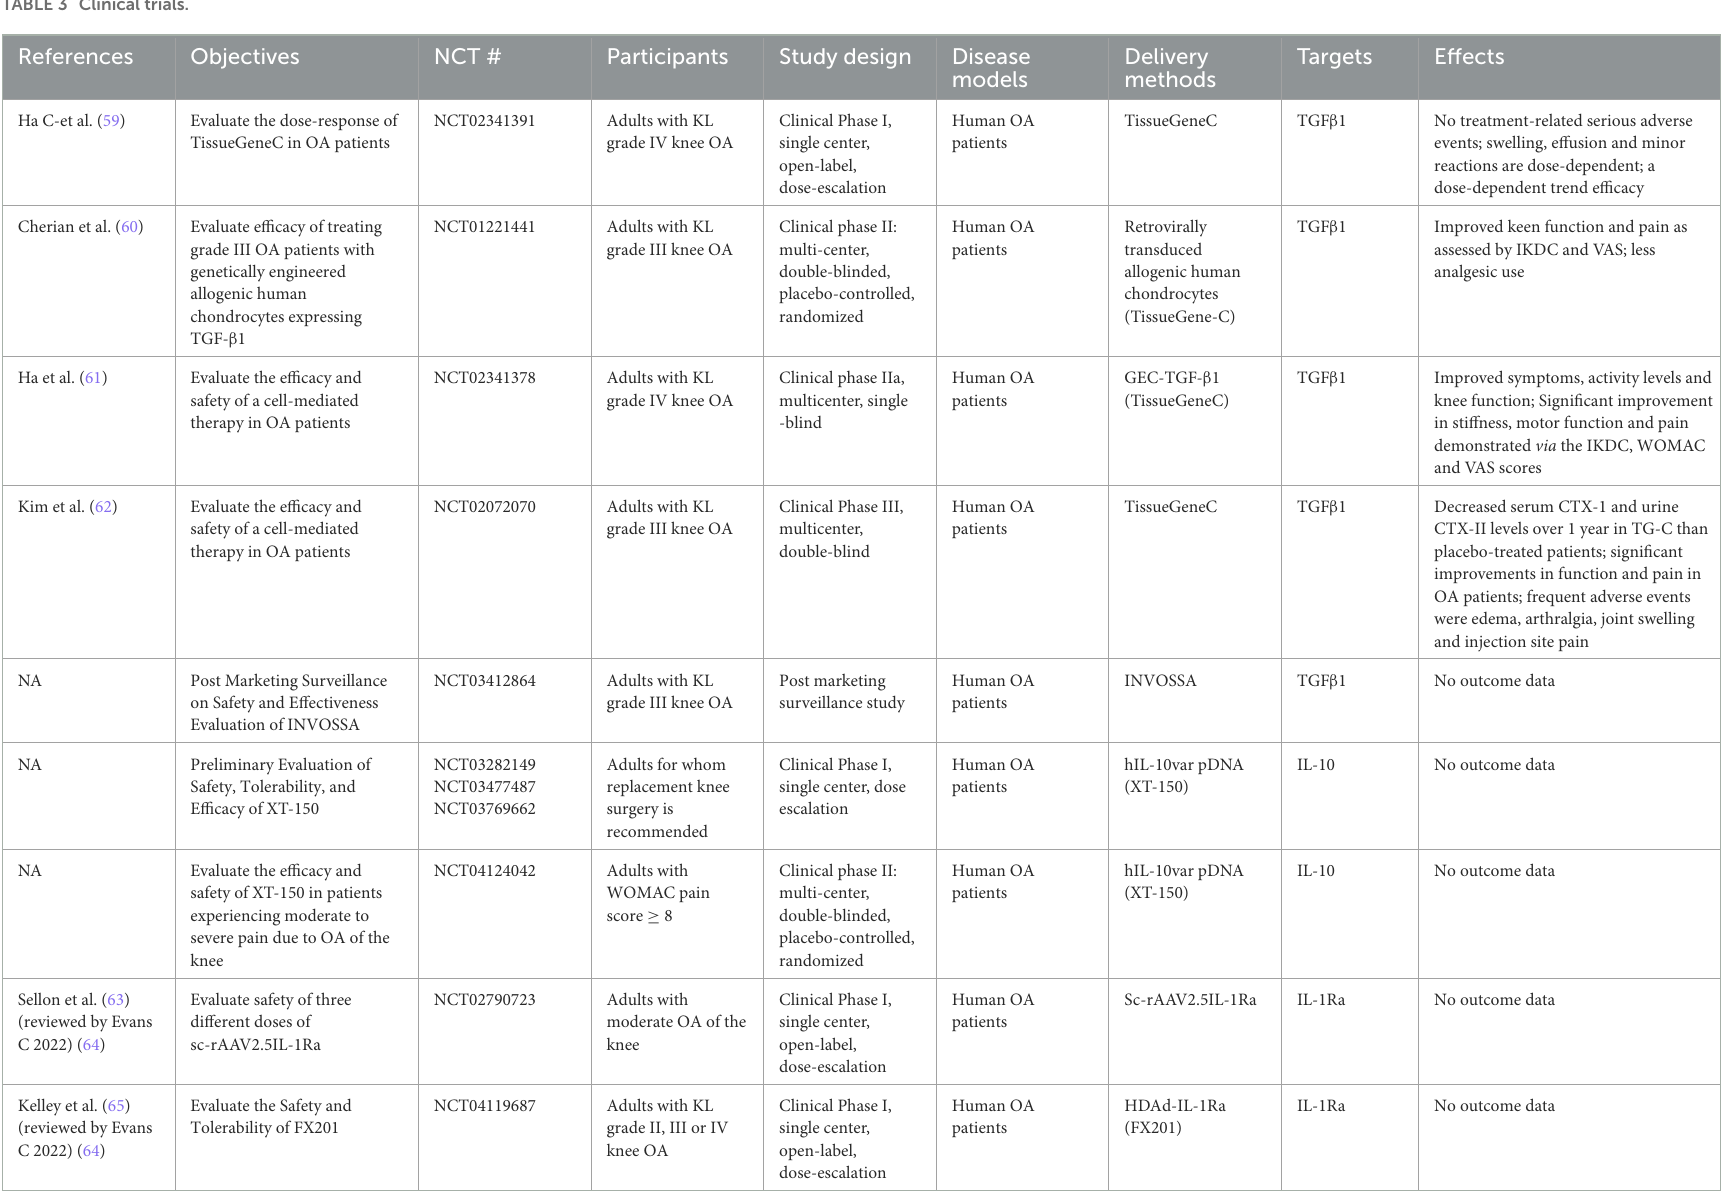
TABLE 3 Clinical